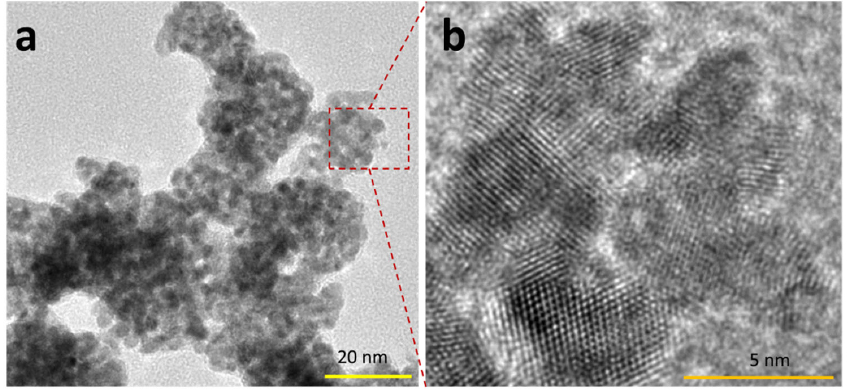
Figure 2. Thin and irregular shape nanostructure product. Low ( a ) and high ( b ) resolution images.